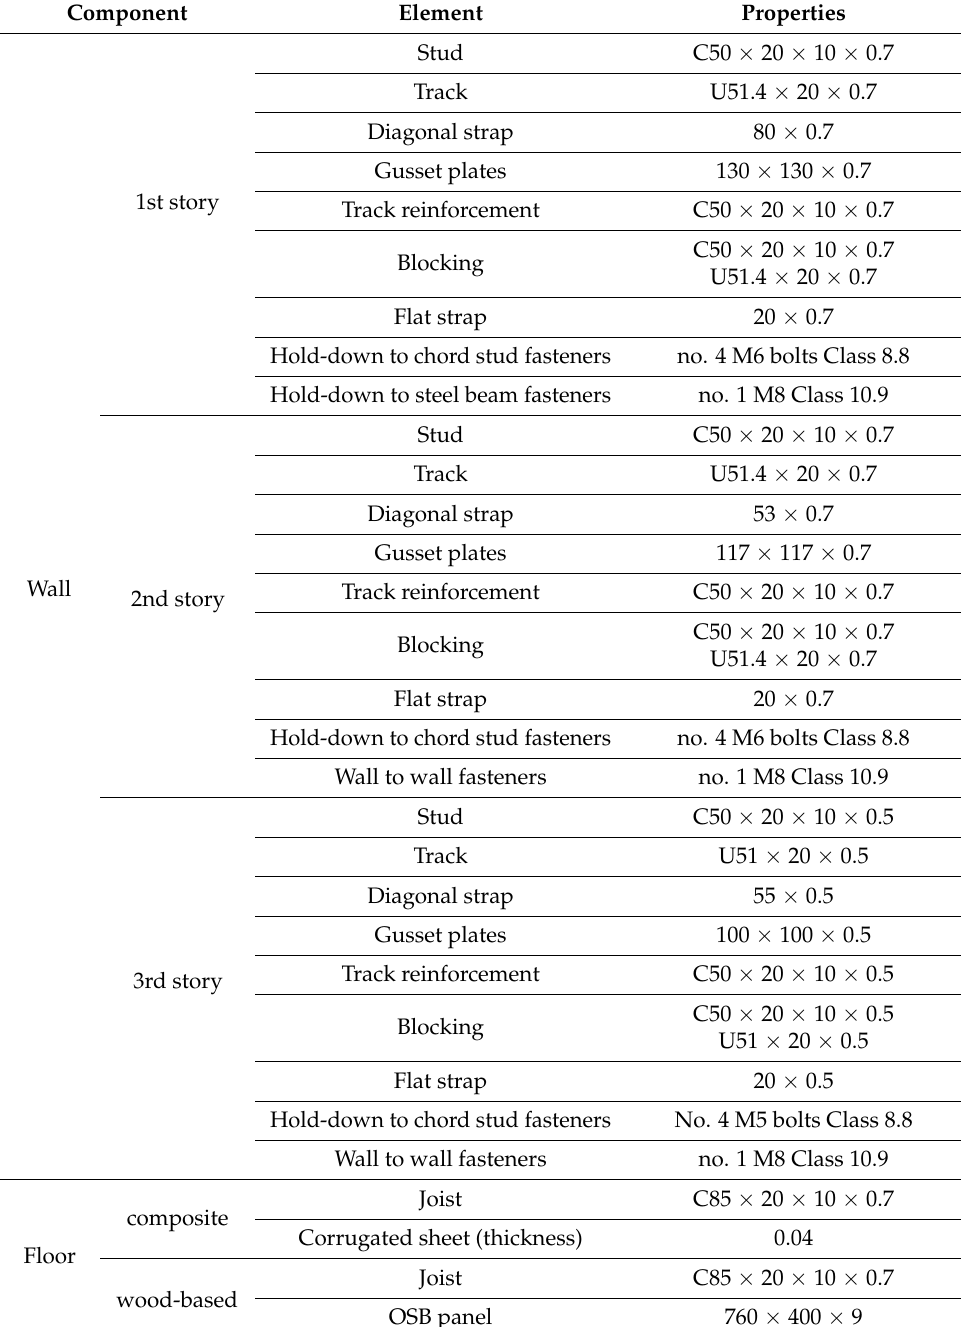
Table 1. Structural element properties (lengths in